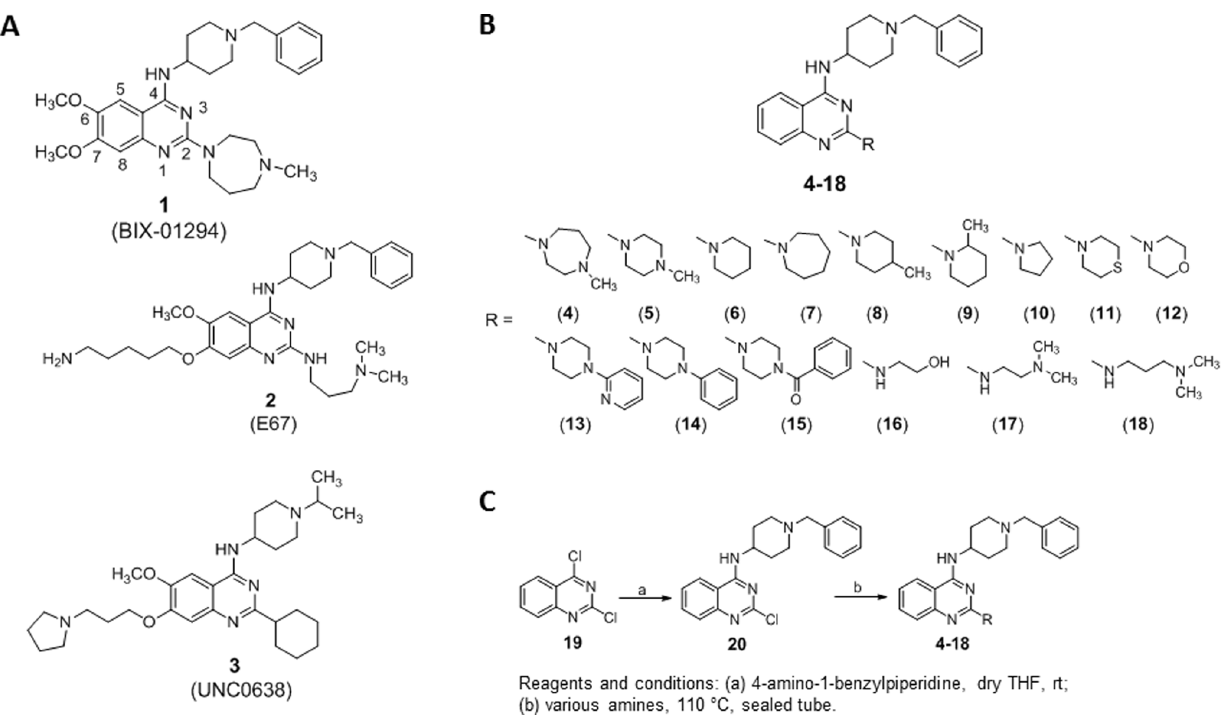
Figure 1. Quinazoline-based modulators of epigenetic targets. (A) Known quinazolines ( 1–3 ) as G9a/GLP inhibitors. (B) Novel 6,7- desmethoxyquinazolines 4–18 . (C) Synthetic scheme for the preparation of 4–18 .